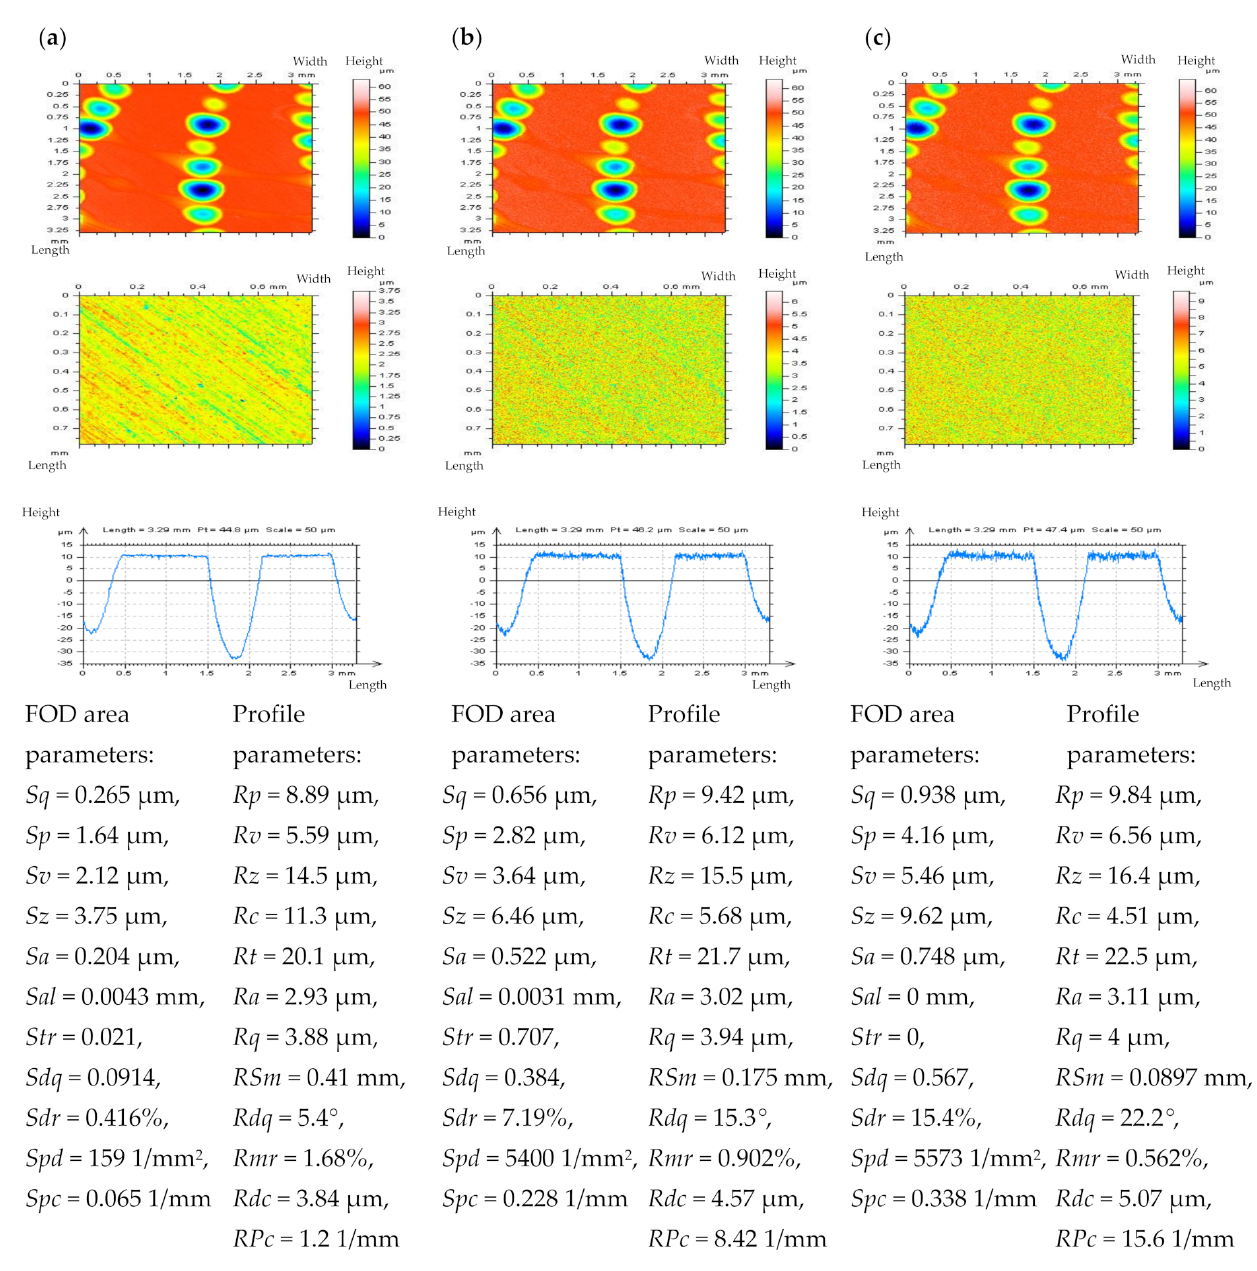
Figure 1. Contour map plots, FOD details, profiles, and select parameters (calculated for FOD areas and profiles) corre- spondingly, extracted from plateau–honed cylinder liner surface texture measured with stylus instrument with 0.5 mm/s ( a ) velocity and with added modelled noise data with amplitude ( Sq ) equal to 10% ( b ) and 20% ( c ) of Sq of the measured